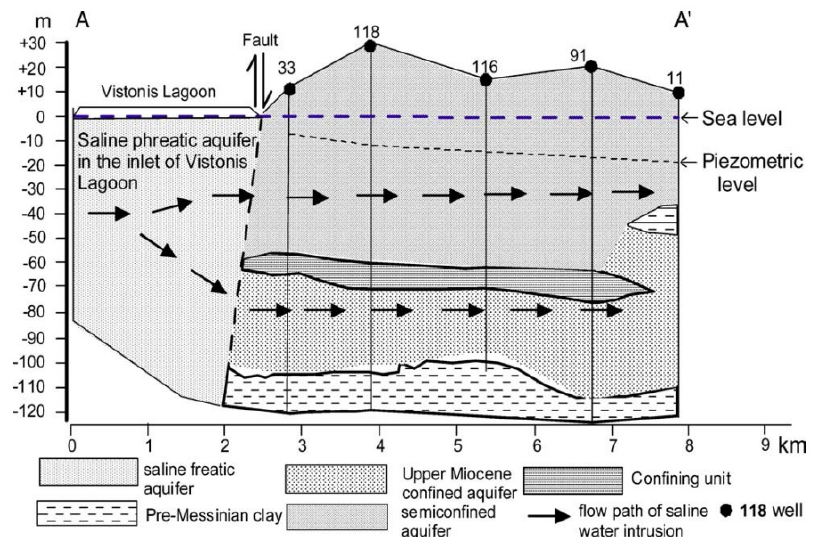
Figure 4. Hydrogeological cross-section (South-North) adopted by Petalas and Lambrakis